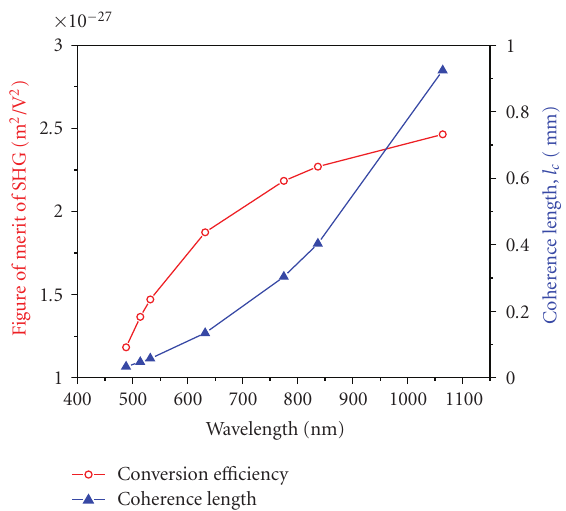
Figure 36: SHG conversion e ffi ciency and coherence length for various input